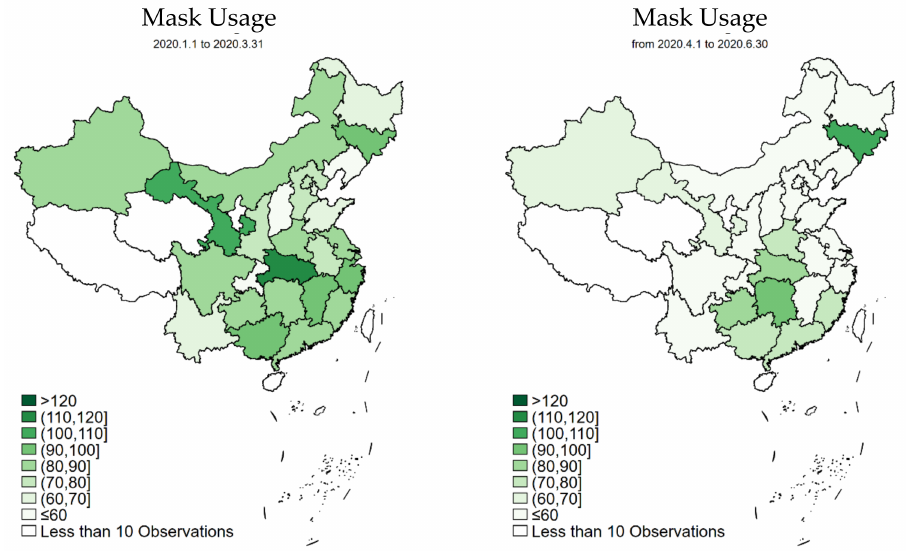
Figure 2. Face mask usage during Period 1 and Period 2 in China at the provincial